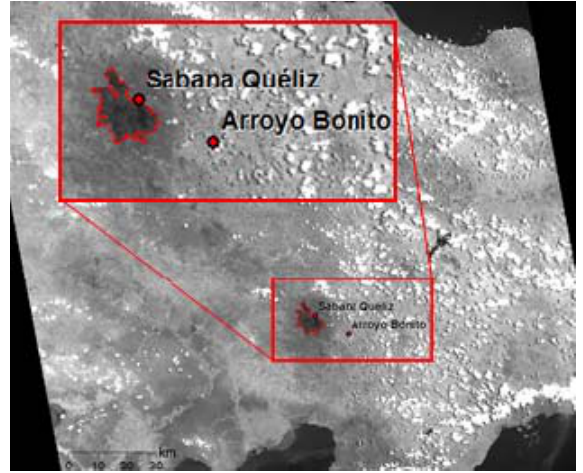
Figure 4: Overview and zoom of mapped burnt area in the Dominican Republic 2014 overlaid on the TET-1 NIR band.